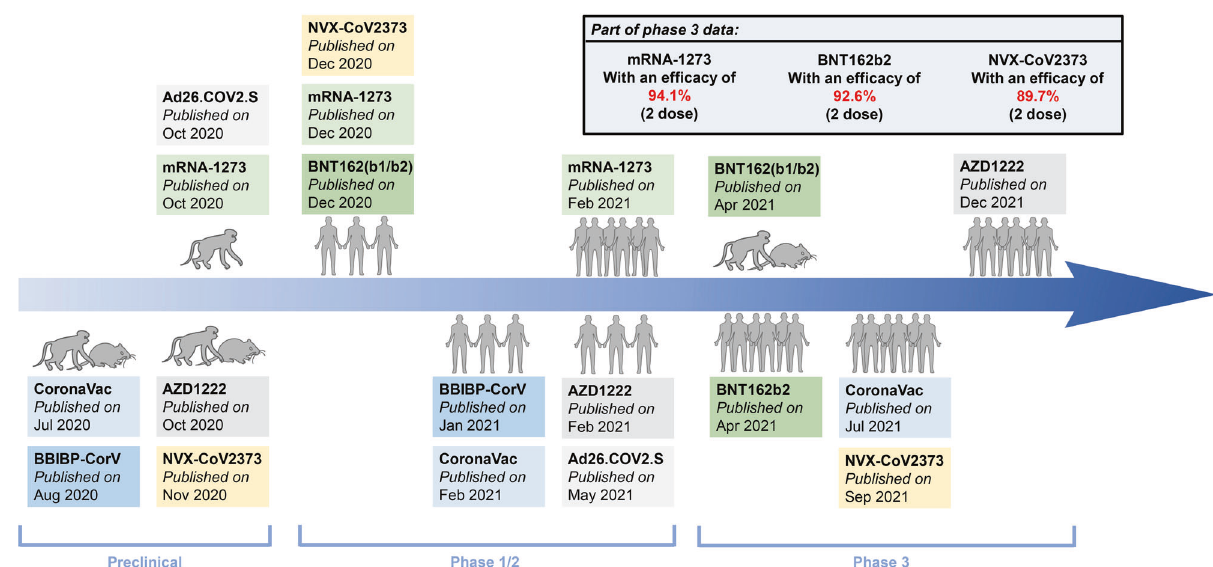
Fig. 6 A timeline of the preclinical and clinical trials of approved COVID-19 vaccines. Preclinical and clinical trials play important roles in evaluating the safety and protective ef fi cacy of COVID-19 vaccines. The information of preclinical to clinical trials of several WHO-approved COVID-19 vaccines are provided in the form of a timeline, and partial Phase III clinical trials ’ data were also displayed to show the total ef fi